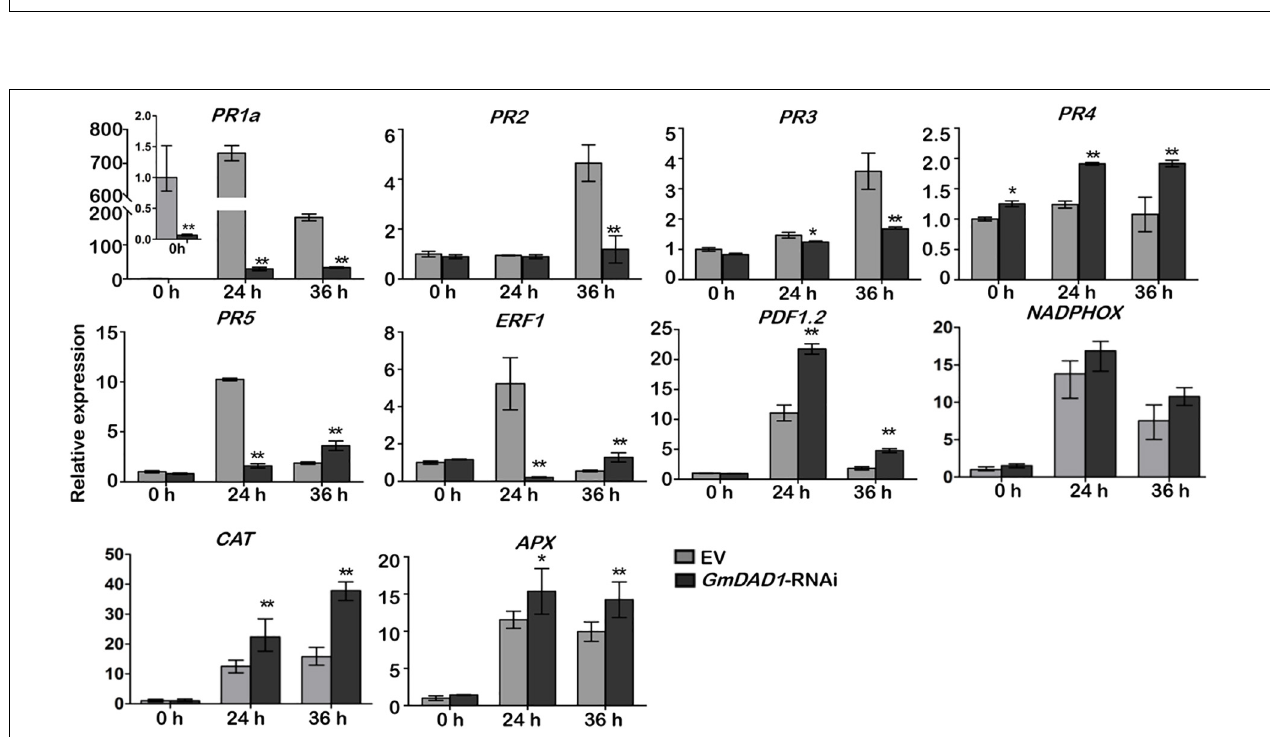
FIGURE 5 | GmDAD1 affects the expression of multiple defense-related genes. RT-qPCR analysis of the expression patterns of defense-related genes in the EV and GmDAD1 -RNAi transgenic hairy roots after inoculation with P. sojae . Values represent the means of three replicates ± SD. Data were analyzed by using Student’s t -tests ( ∗ P < 0.05, ∗∗ P < 0.01 compared with the control).